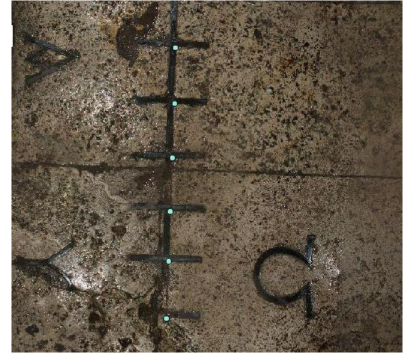
Figure 9. Detail of points measured on the sundial